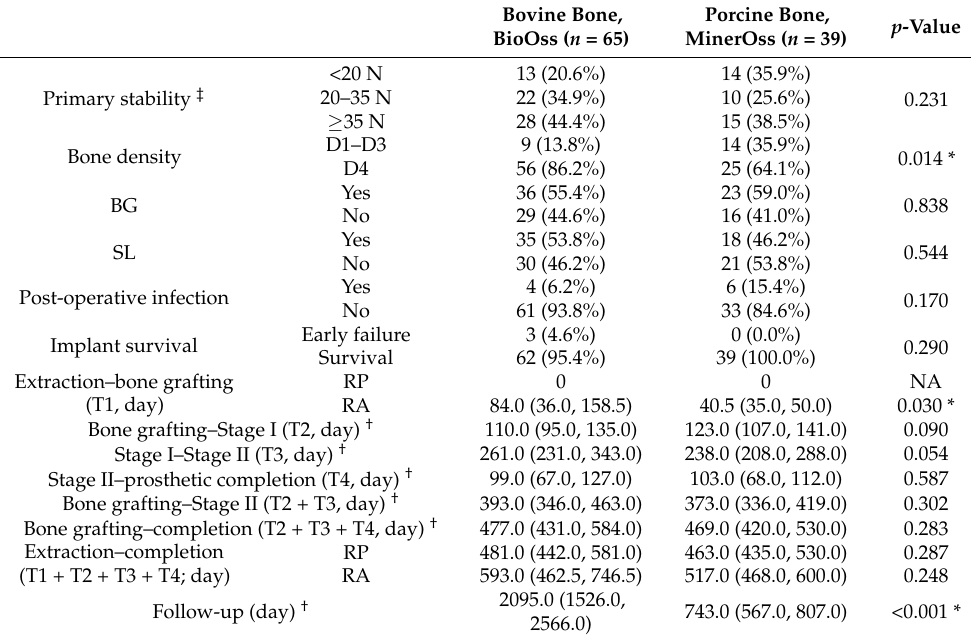
Table 3. Implant site development for bovine and porcine bone groups at maxilla implant sites.